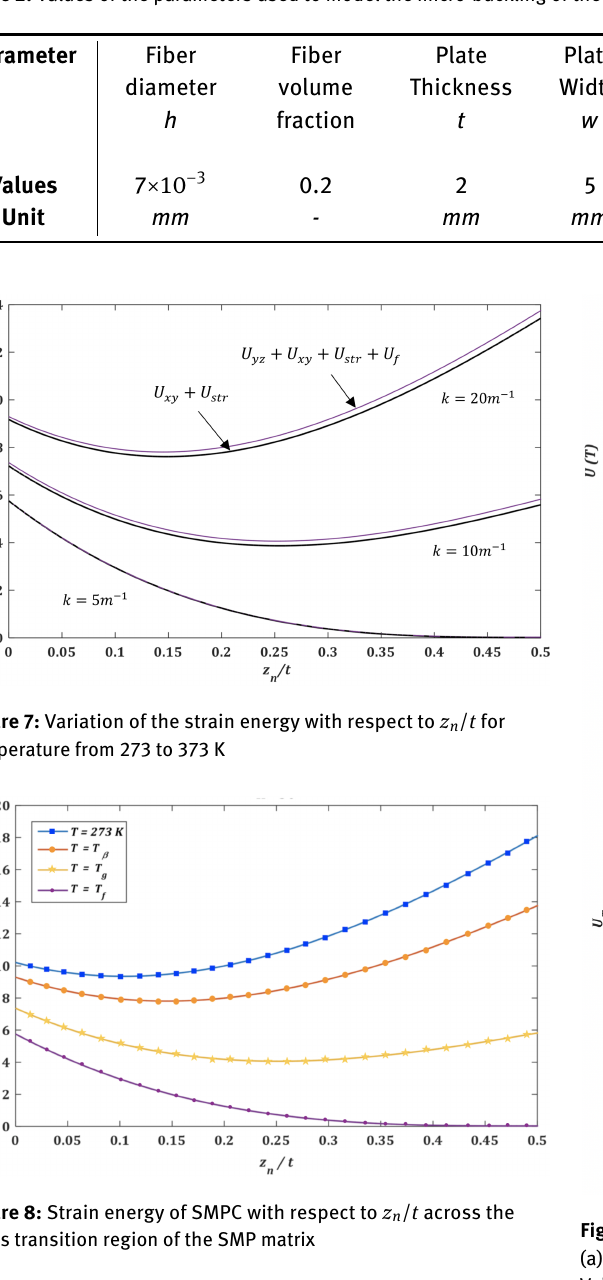
of the SMP in its glass transition region, as indicated in Figures 6(a) and